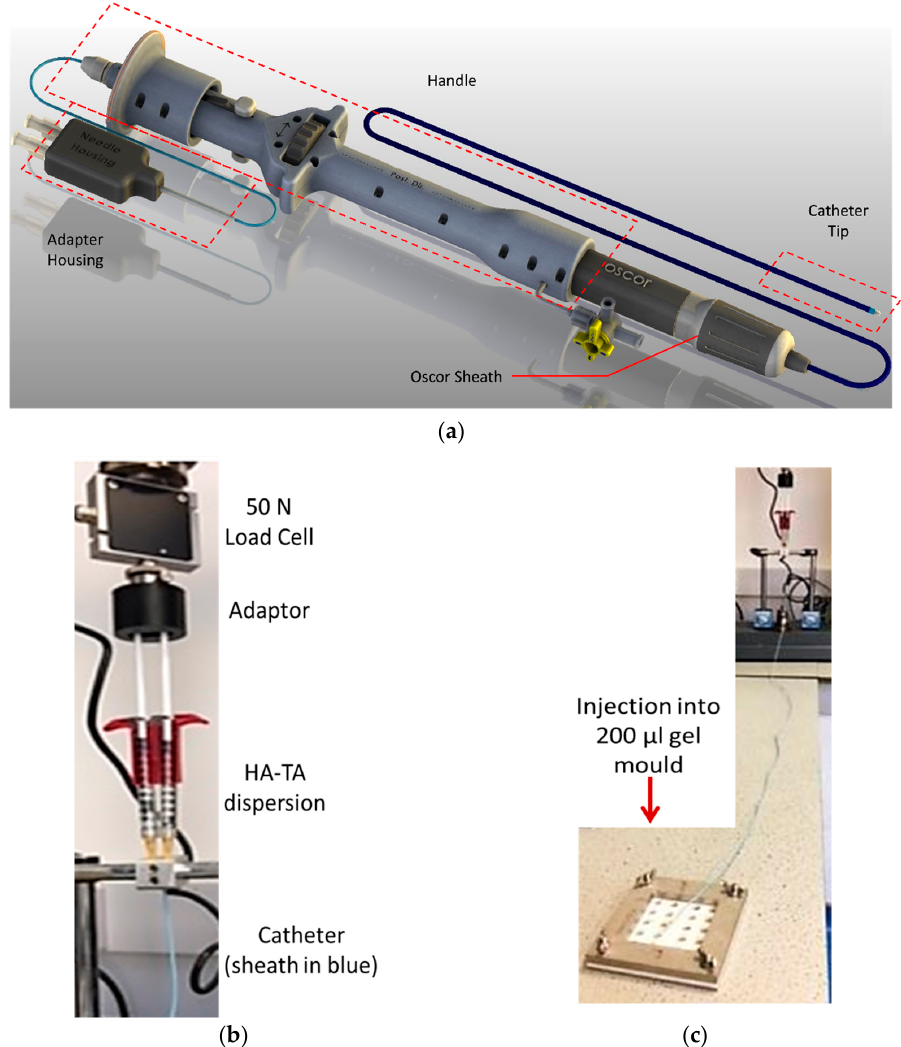
Figure 2. ( a ) The AMCath catheter used for hydrogel injection (Adapted from [35], SAGE Publica- tions, 2018). ( b ) Syringes containing nano-VEGF-HA-TA attached to the prototype catheter and containing nano-VEGF-HA-TA attached to the prototype catheter and connected via a 3D printed adaptor to the 50 N load cell of the Zwick for testing the force required for injection. ( c ) Full length of catheter; tip is set to inject into the 200 µ L injection mold